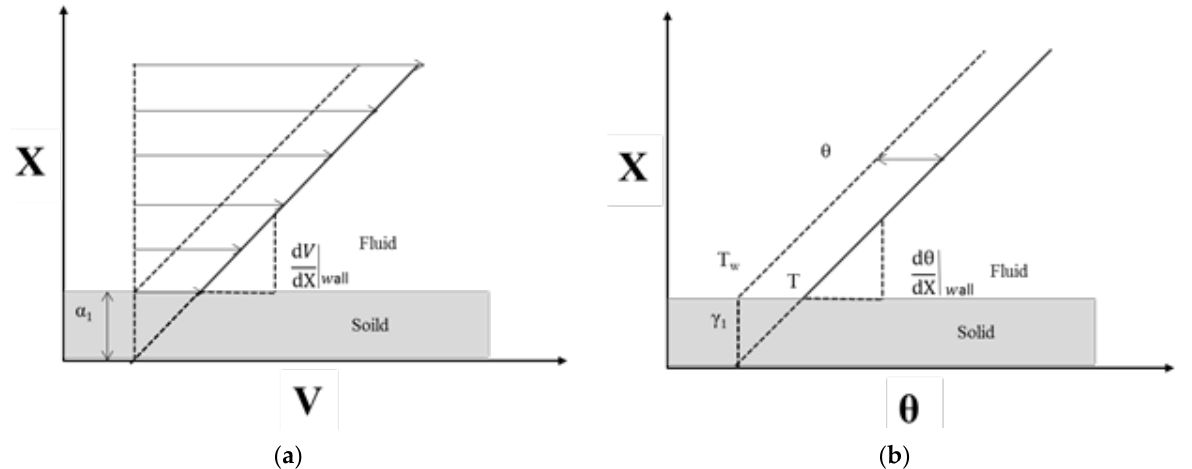
Figure 3. Slip and jump boundary conditions. ( a ) Velocity-slip boundary condition. ( b ) Tempera- ture-jump boundary